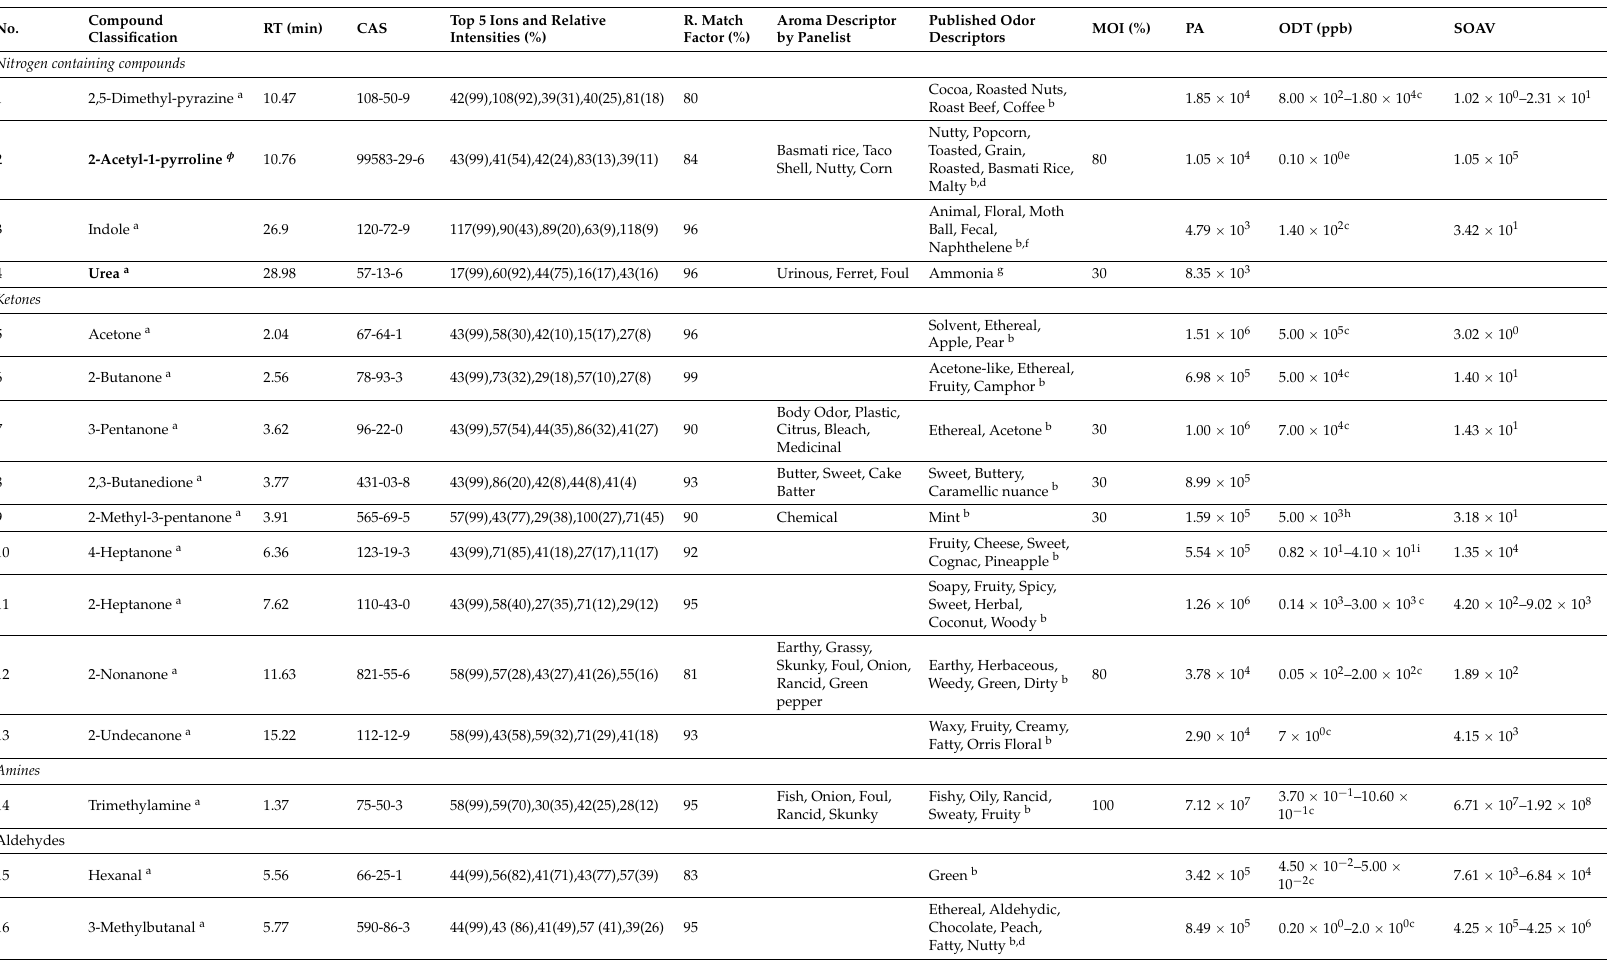
Table 2. A list of all the VOCs in the marking fluid of P. tigris altaica identified using GC-MS-O. Bolded entries are compounds that are characteristic of the total aroma of tiger MF. Compounds were identified using spectral matches with the top five ions, odor descriptor matching, chemical standard confirmation (except for 2-AP), retention time, and the NIST library spectral